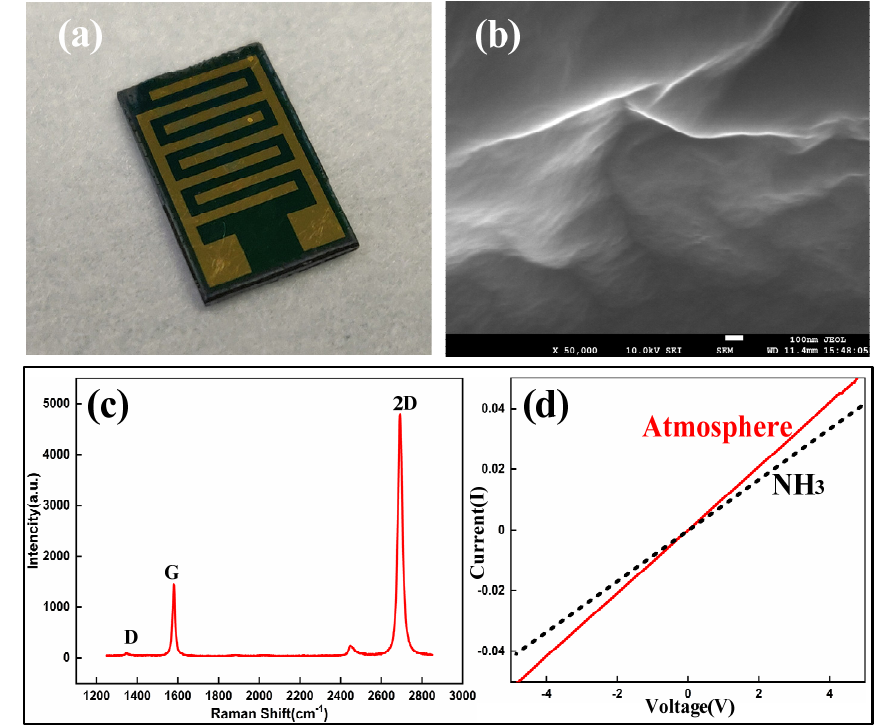
Figure 3. Single-layer graphene transferred onto a Si/SiO 2 substrate. ( a ) Picture of the device, ( b ) the SEM of graphene, ( c ) the Raman spectra of single layer graphene, and ( d ) the I–V curves of metal and graphene ohmic contact.